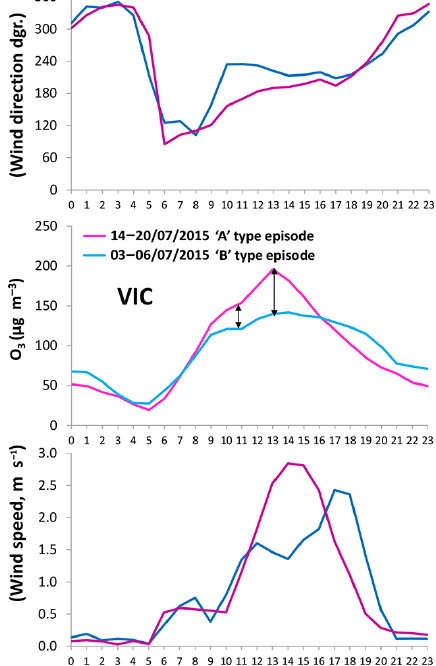
cal production from precursors. On the other hand, the sec- ond O 3 concentration “hump” is coincident with maximum